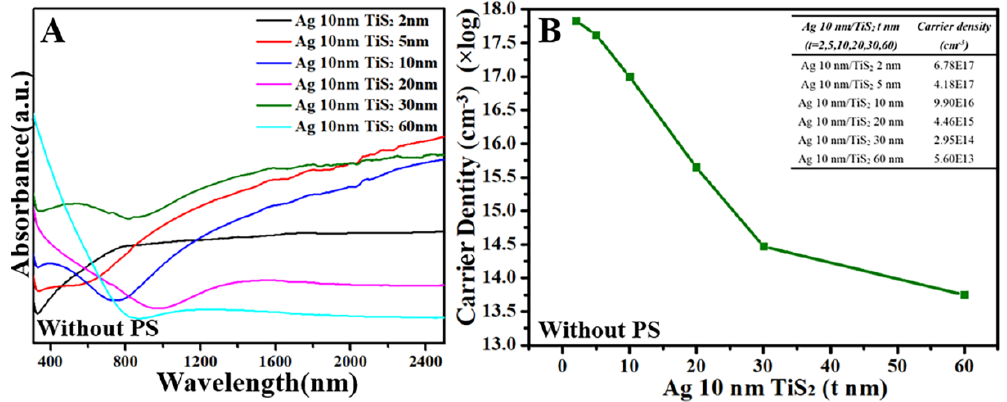
Figure 6. ( A ) UV–Vis–NIR spectra and ( B ) Hall effect for the Ag 10 nm/TiS 2 (t nm) nanostructures without PS, and the table inset is the raw data.